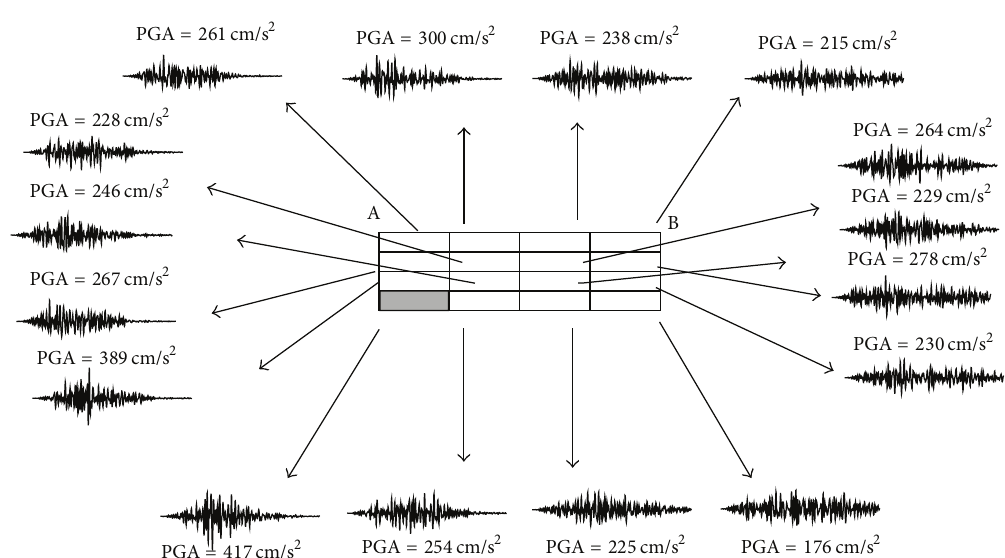
Figure 7: Simulated acceleration records at Gopeshwar station for parameters of the Chamoli earthquake on 29 March, 1999, by considering all possibilities of nucleation point within the rupture plane. The shaded rectangle shows the nucleation point which gives maximum ground acceleration.